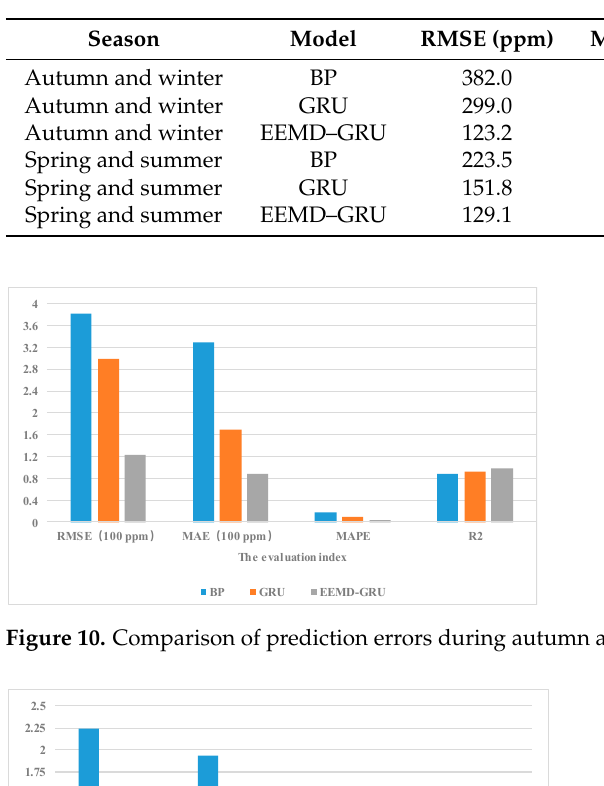
Table 5. Comparison of prediction errors of the three models.